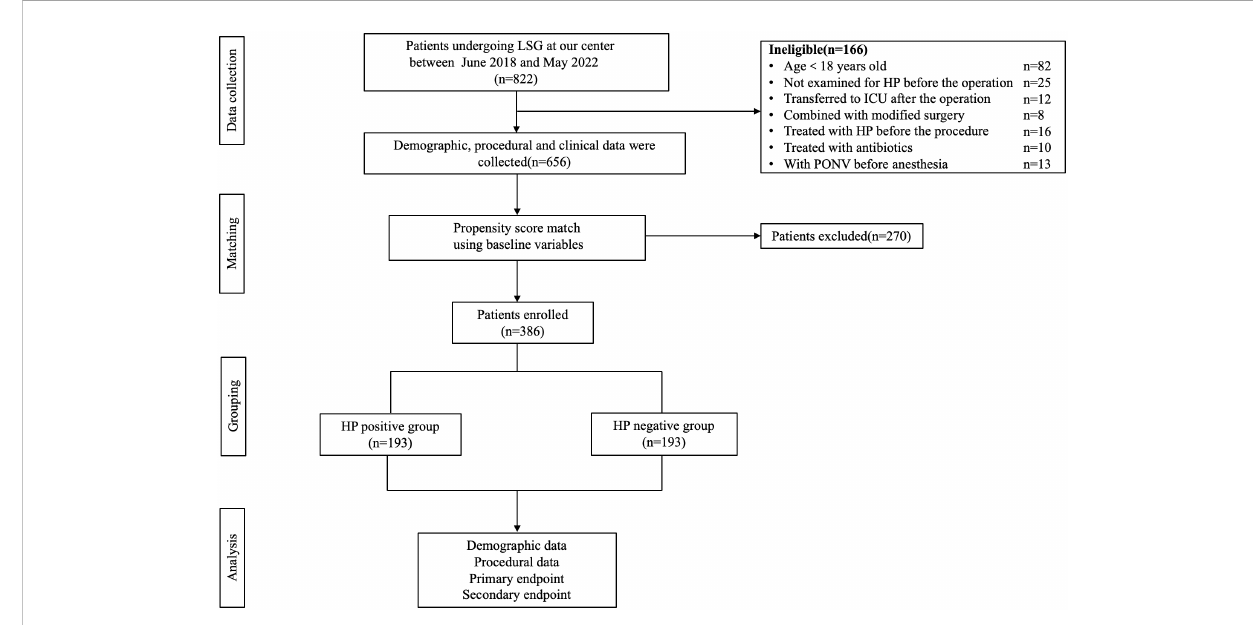
FIGURE 1 Flow diagram of this